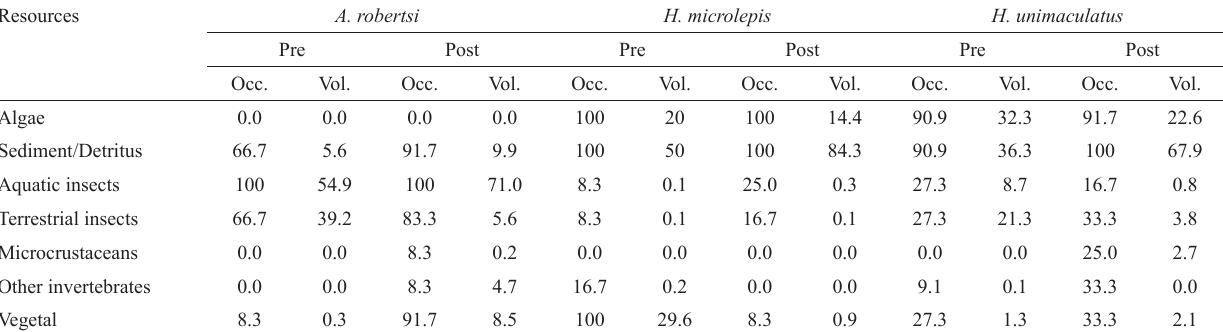
Table 4. Feeding resources (occurrence and volume, %) consumed by A. robertsi , H. microlepis , and H. unimaculatus , before and after the construction of Lajeado Reservoir. N = 12 fish/period for each species. Occ = ?; Vol. =